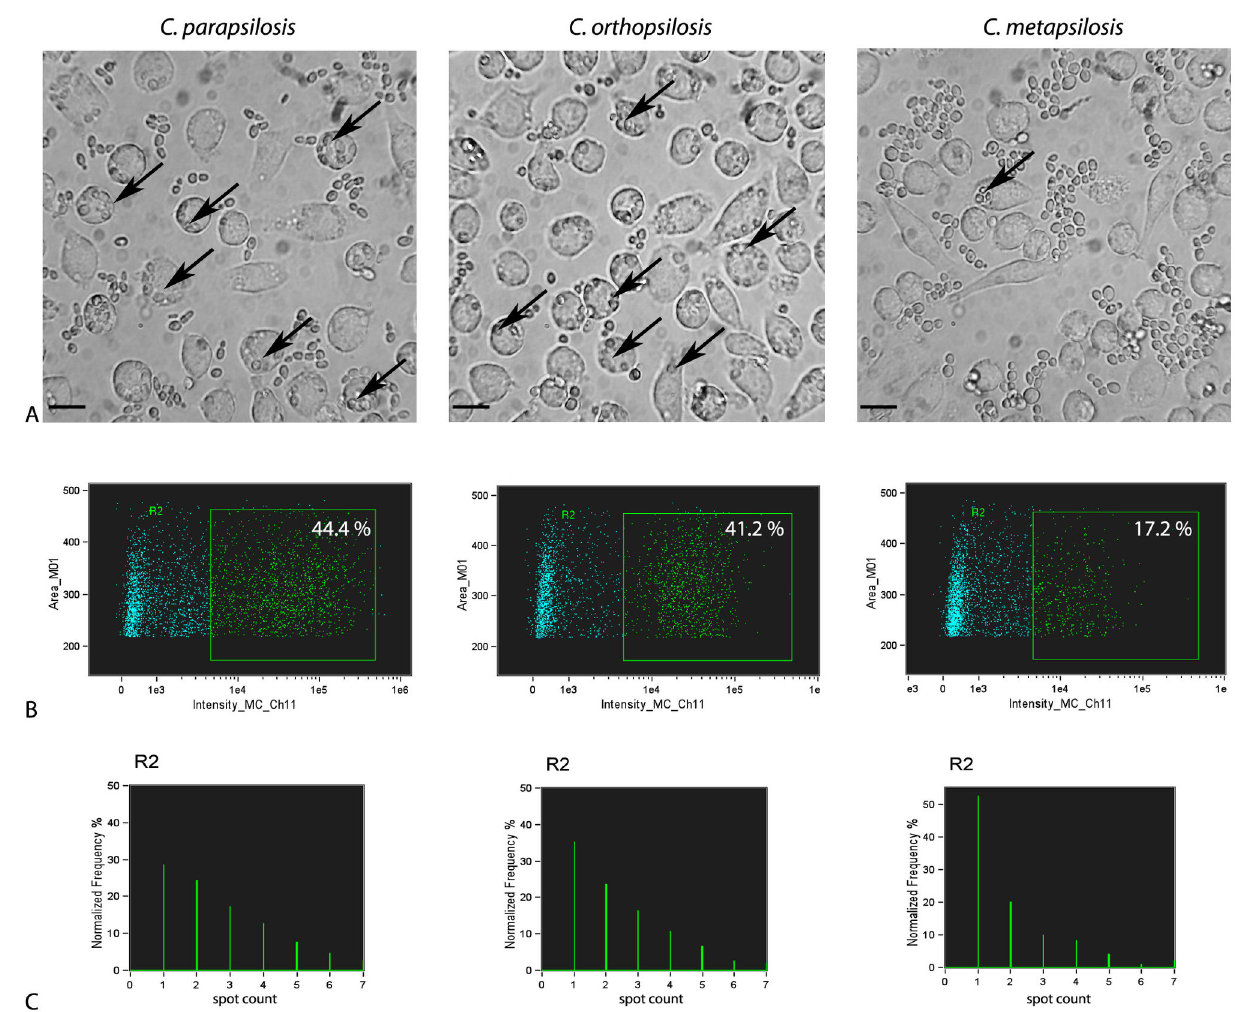
Figure 3. Phagocytosis of one representative isolate each of C. parapsilosis sensu stricto , C. orthopsilosis and C. metapsilosis by J774.2 macrophages. (A) Light microscopic picures of J774.2 macrophages phagocytosing C. parapsilosis sensu lato species, (B) phagocytosis of C. parapsilosis sensu stricto , C. orthopsilosis and C. metapsilosis by J774.2 macrophages assessed by quantitative imaging, R2: phagocytosing macrophage population discriminated by the presence of red fluorescence due to ingestion of Alexa Fluor 647-labeled yeast cells, (C) numbers of ingested yeast cell/macrophage in the R2 population in case of C. parapsilosis sensu stricto , C. orthopsilosis and C. metapsilosis determined by the spot-counting feature of IDEAS software.